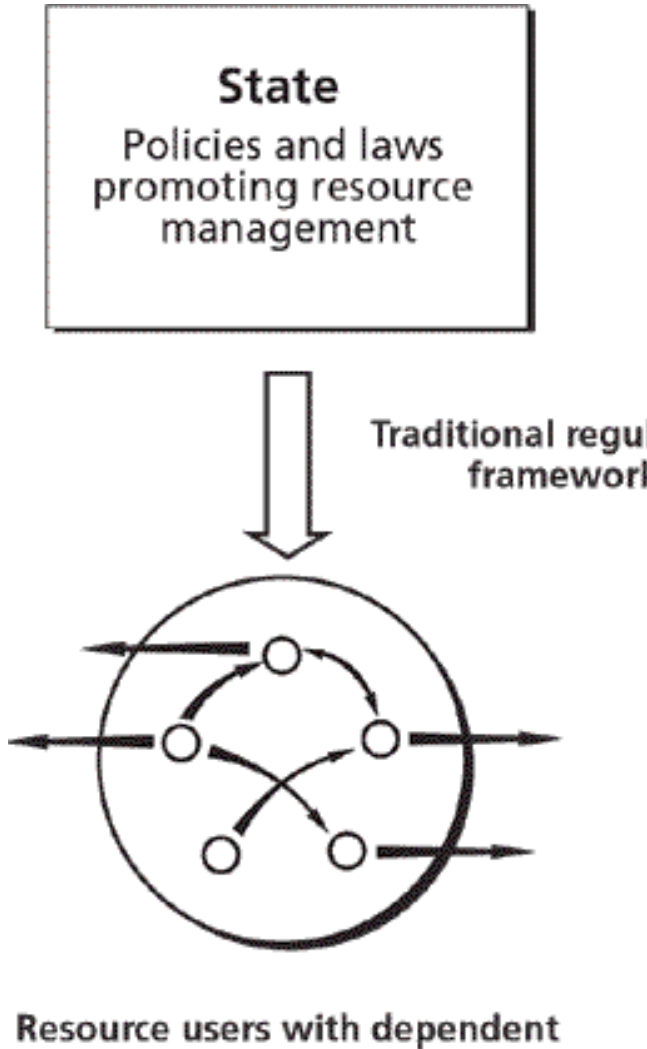
Fig. 1 . A representation of traditional resource management interactions between government and resource